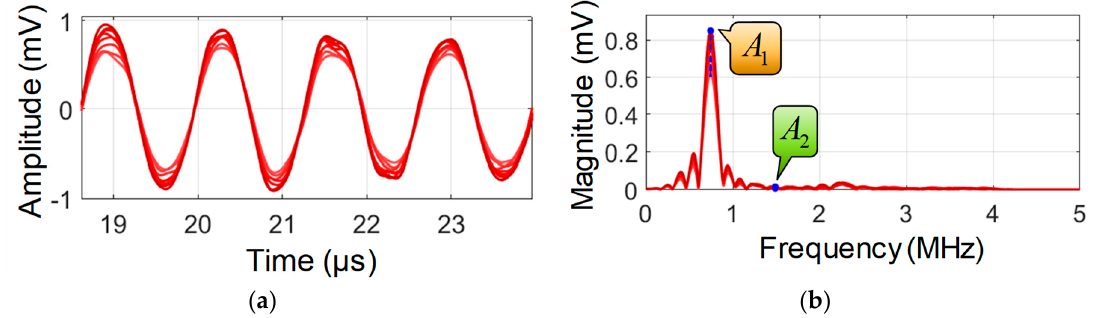
Figure 7. The laser-generated SAWs with respect to the laser intensity; ( a ) waveforms; ( b ) their frequency spectra.